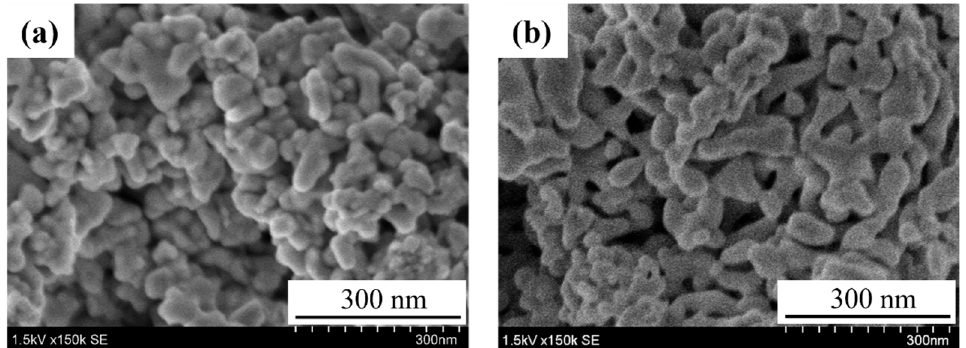
Figure 6. SEM images of the surface of the SmFeO 3 detection layers of sample A ( a ) and B ( b ) sintered at 600 °C.